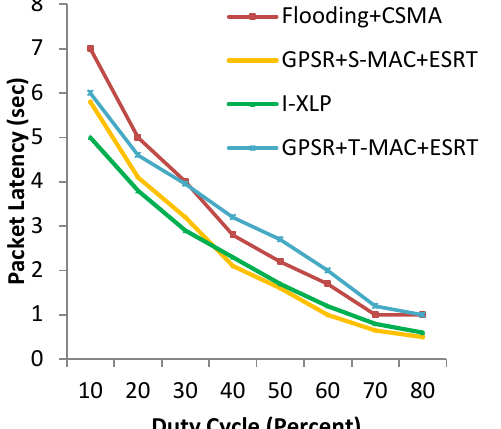
Fig. 10 Average latency vs. duty cycle (for non- prioritized traffic).